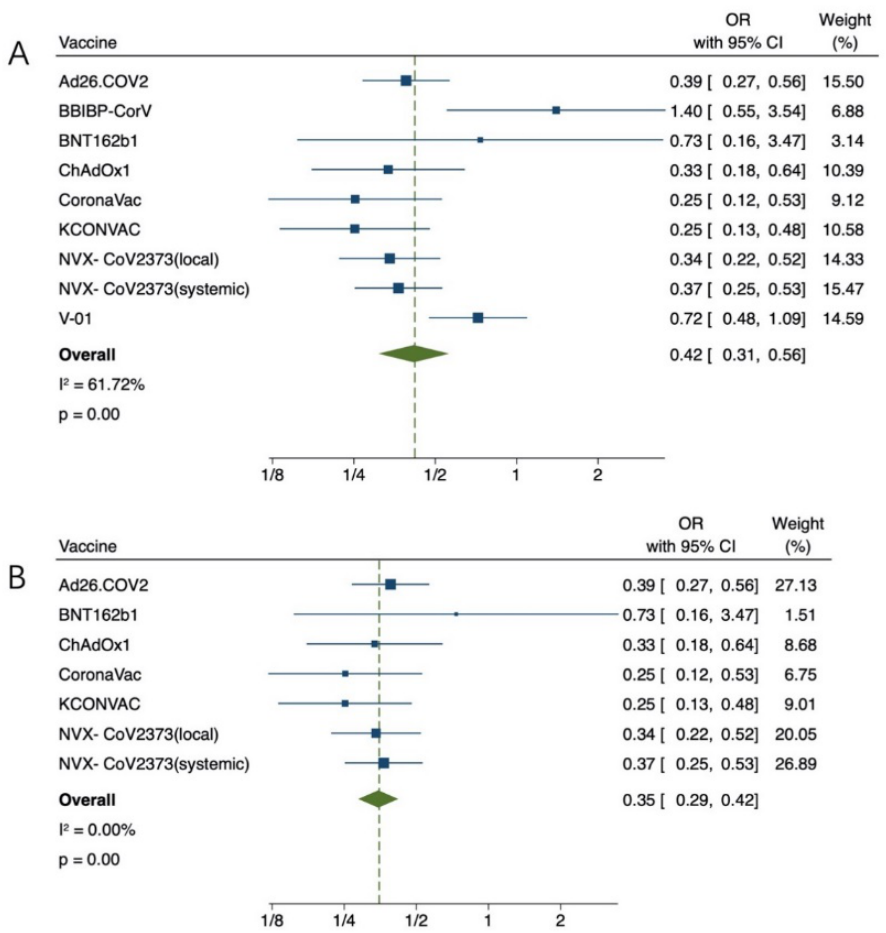
Figure 5. ( A ) Meta-analysis of any AEs between the experimental group (older adults) vs control group (young adults). ( B ) After removing the heterogeneity, Meta-analysis of any AEs between the experimental group (older adults) vs control group (young adults). Blue squares represent effect sizes for a single study, and green rhombus represent pooled results for all studies.